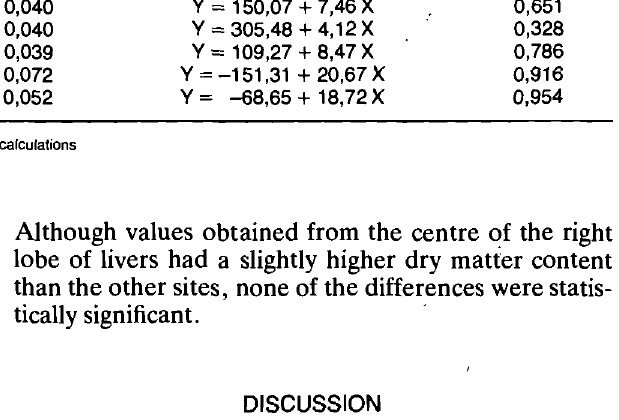
Table 2: LIVER MASS OF SHEEP AS A PERCENTAGE OF BODY MASS AND THE RELATIONSHIP BETWEEN LIVER MASS AND BODY MASS Trial Wet liver as a proportion Dry liver as a proportion Relationship of wet liver mass of body mass of body mass (Y in g) to body mass (X in kg) % ± SO % ± SO Regression